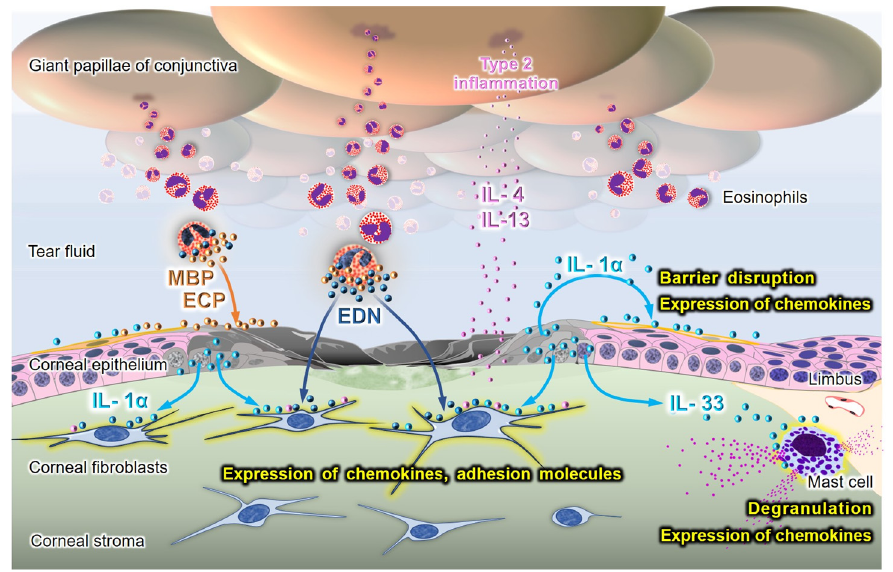
Figure 3. Involvement of alarmins in the pathogenesis of corneal lesions in severe ocular allergic diseases. Alarmins from damaged epithelial cells and eosinophils exacerbate the allergic inflamma- tion and corneal lesions through barrier disruption and recruitment of eosinophils. IL; interleukin, EDN; eosinophil-derived neurotoxin, MBP; major basic protein, ECP; eosinophil cationic